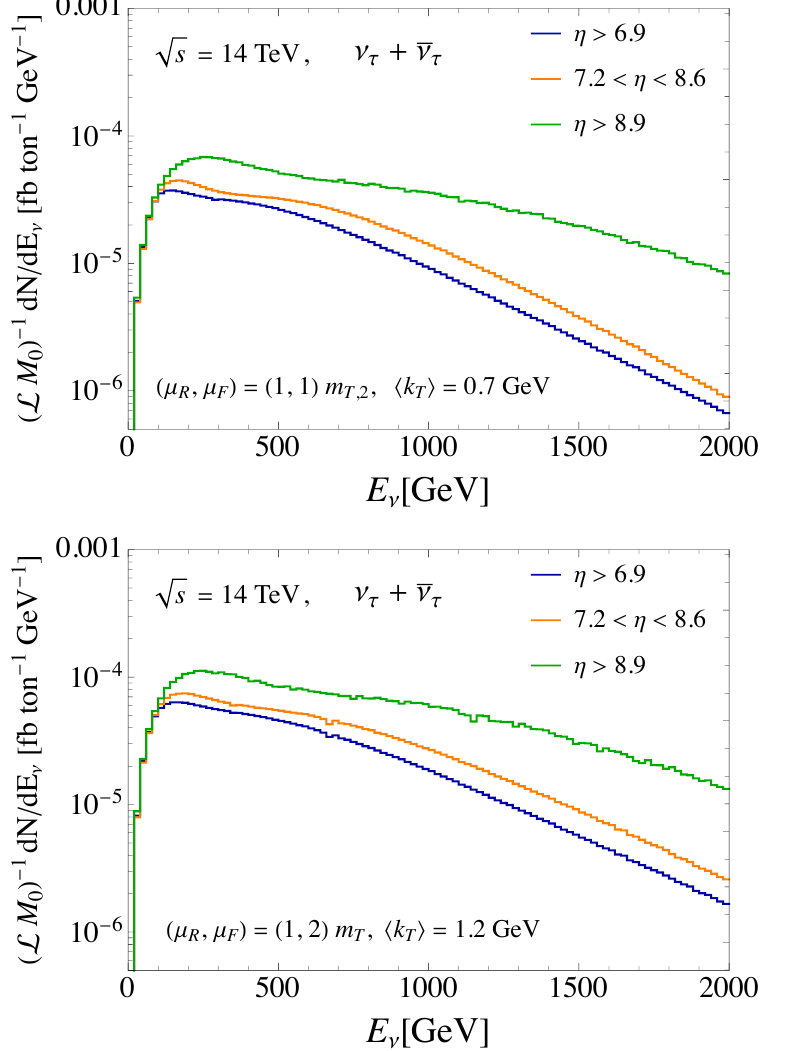
Figure 21. The energy distributions of the total charged-current events of tau neutrinos and antineutrinos per ton at a distance D d = 480 m from the collider interaction point for different rapidity ranges, using as input parameter sets ( µ R , µ F ) = (1 , 1) m T, 2 and h k T i = 0.7 GeV (upper) and ( µ R , µ F ) = (1 , 2) m T and h k T i = 1.2 GeV